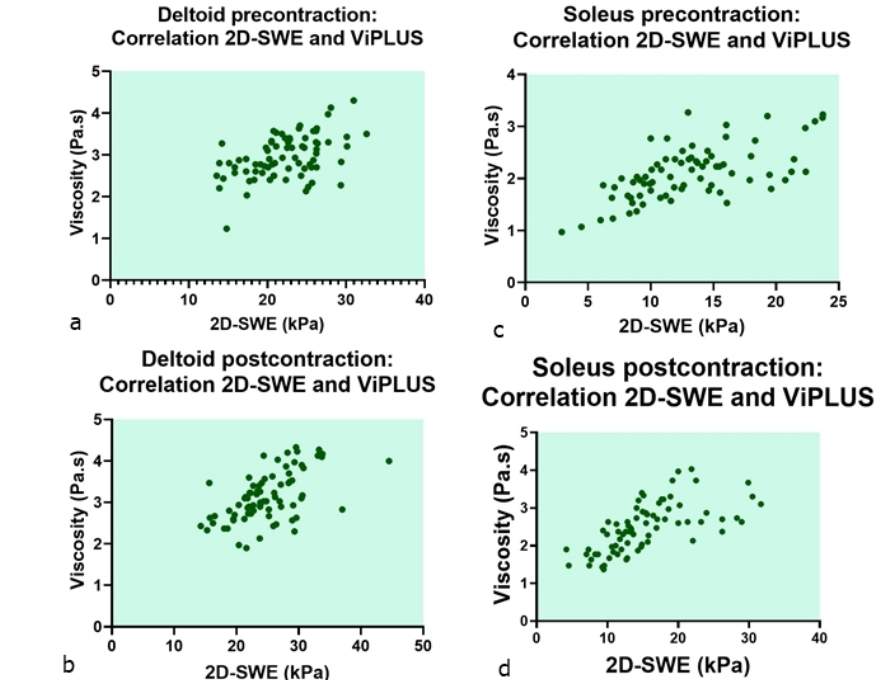
Figure 6. Scatter plot observing the relationship between the elastographic and viscosity data in both muscle groups in pre- ( a , c ) and post-contraction ( b , d ), showing a moderate to high positive correlation.